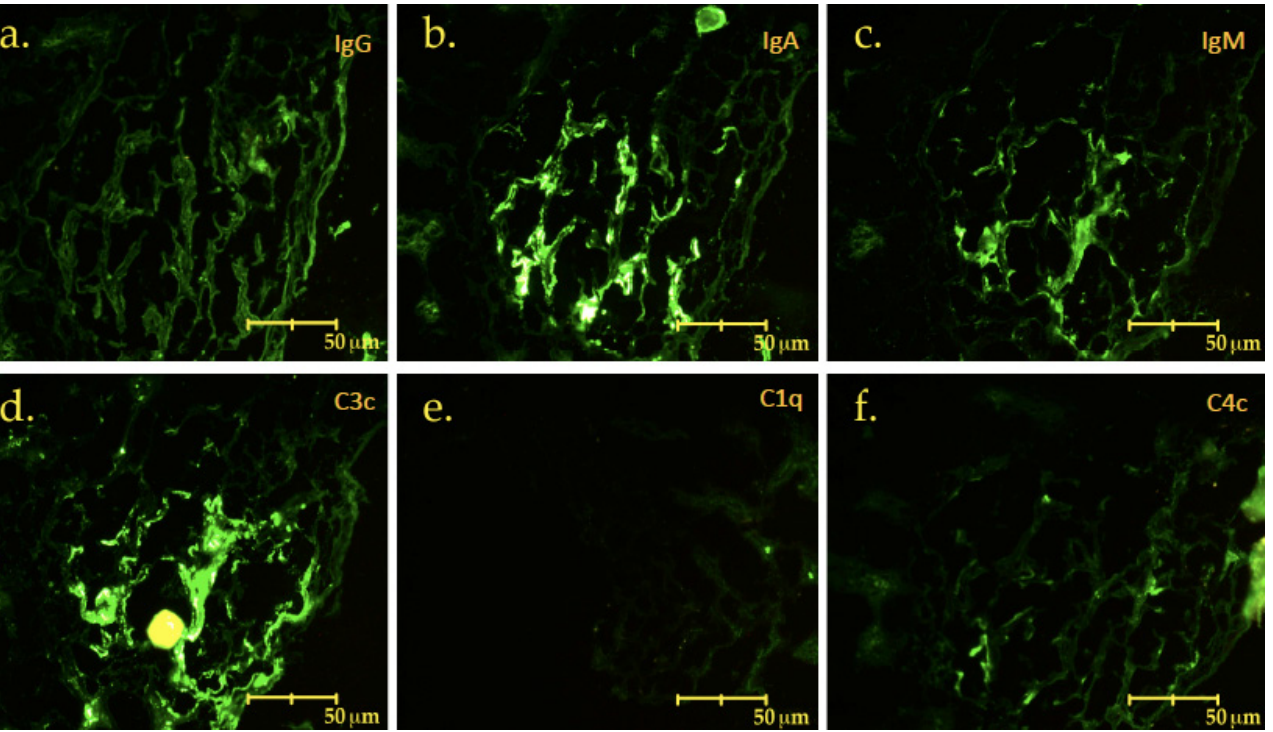
Figure 4. 400× direct immunofluorescence study that showed dominance positivity for IgA ( b ), with little IgM ( c ) and mesangial deposits of C3 ( d ) that allow us to conclude with the diagnosis of IgA